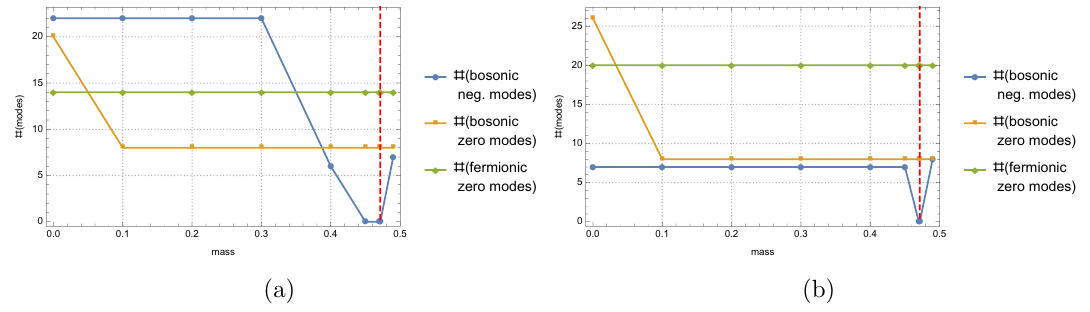
for the C [(1 ; 0)] + C [(0 ; 1)] + D V